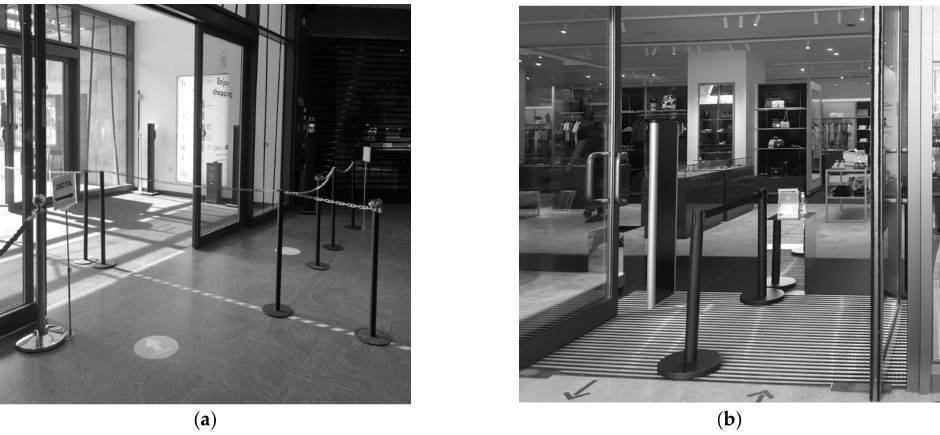
Figure A6. Images illustrating examples of route-demarcating devices (G) separating the entrance and exit paths through suspended colored chains ( a ) or tapes ( b